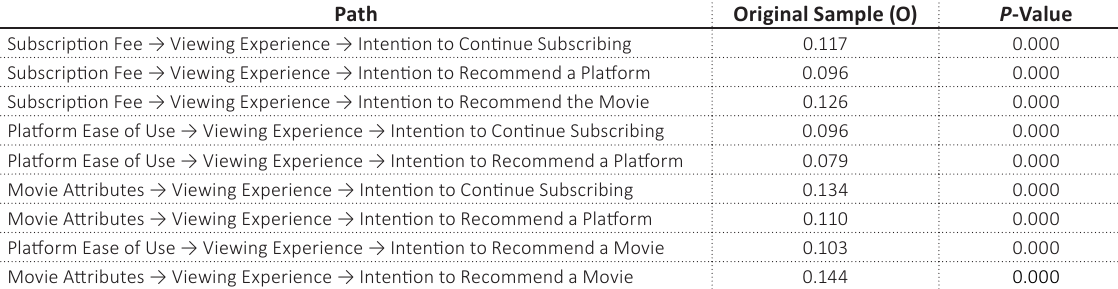
Table 5. Specific indirect effect